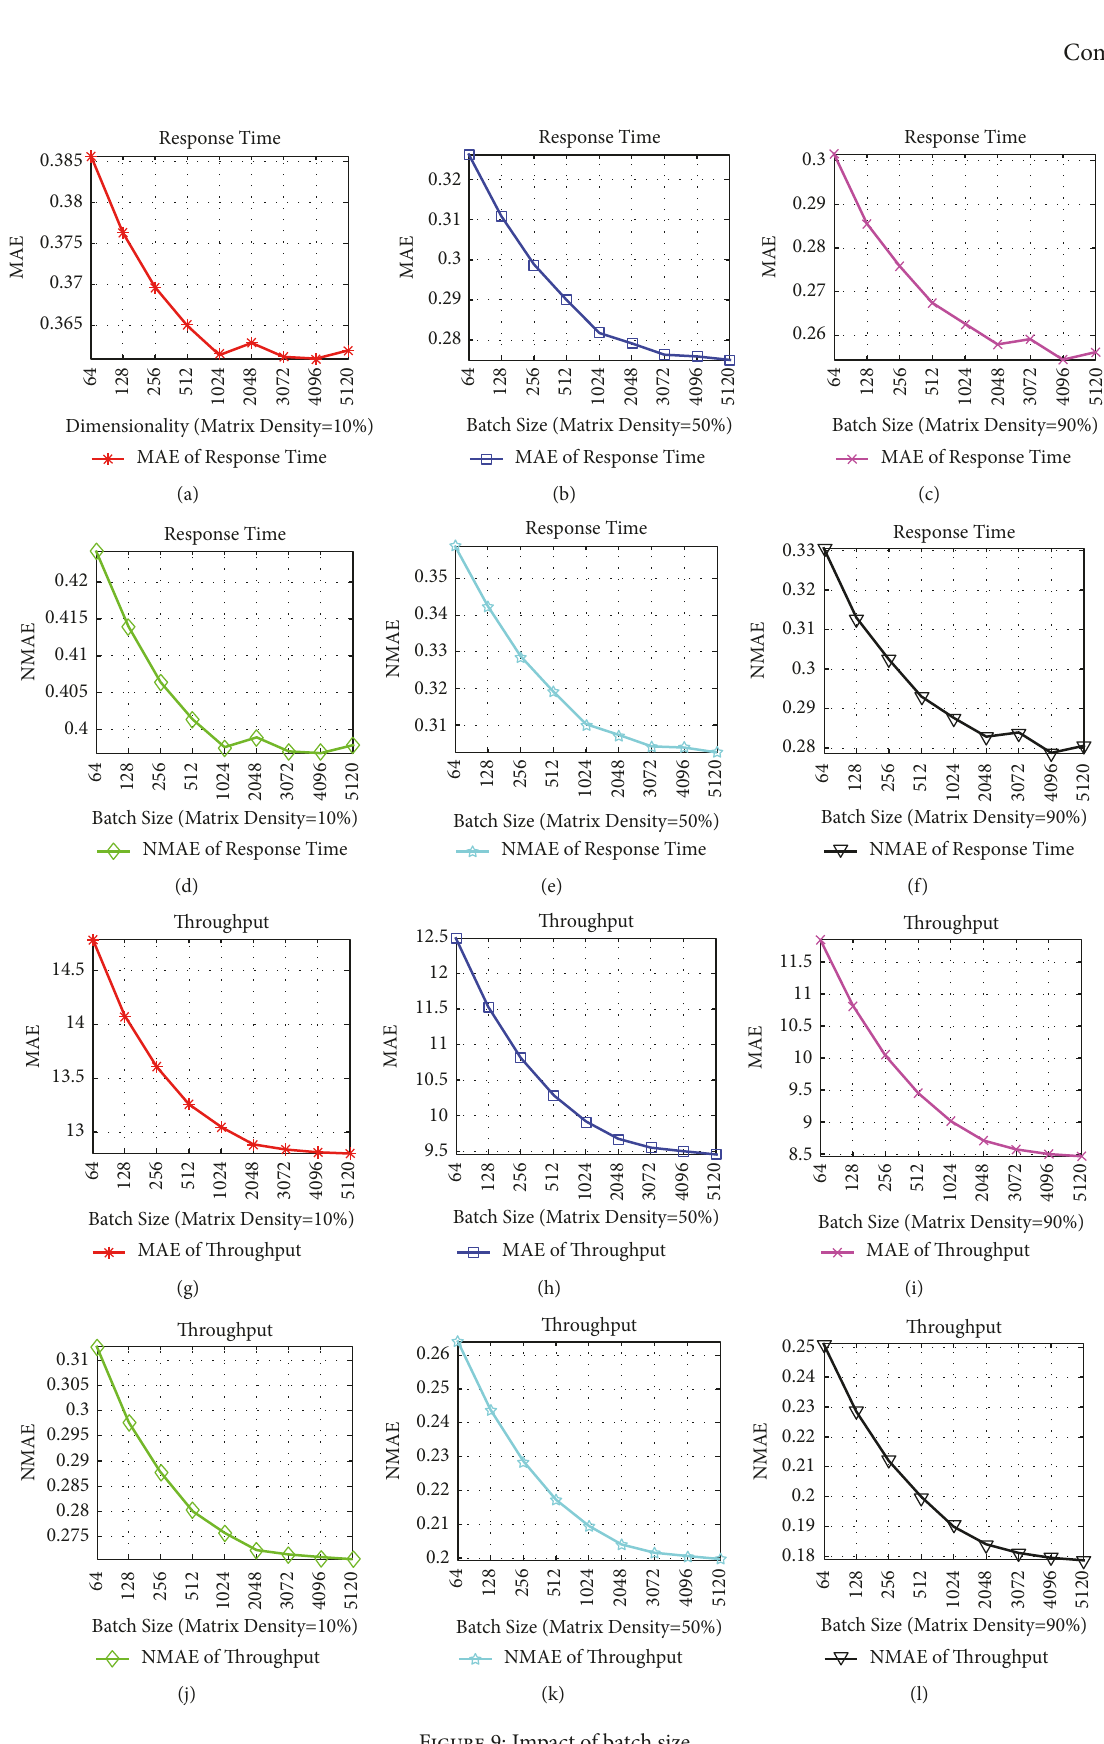
Figure 9: Impact of batch